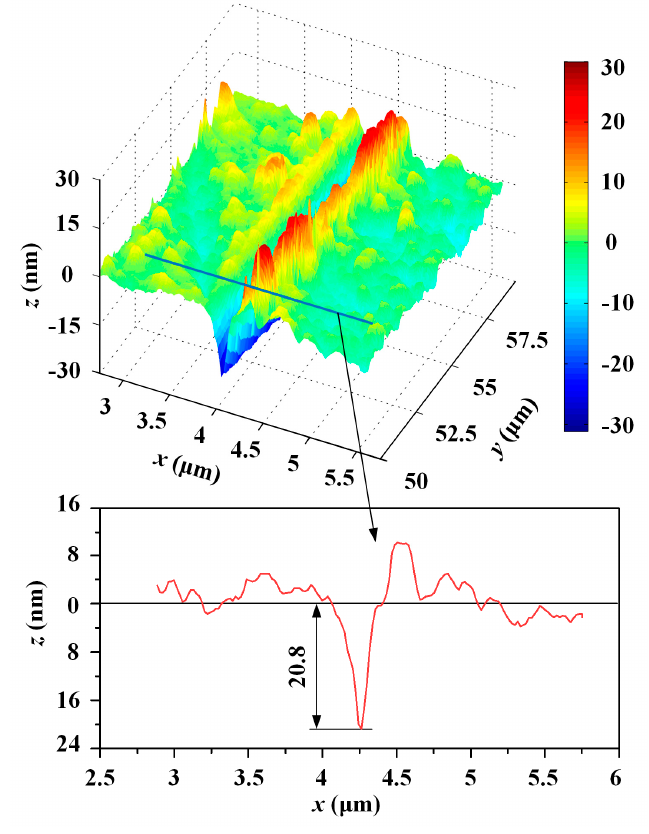
Figure 9. In situ SPM images. Table 3. Repeated test results.